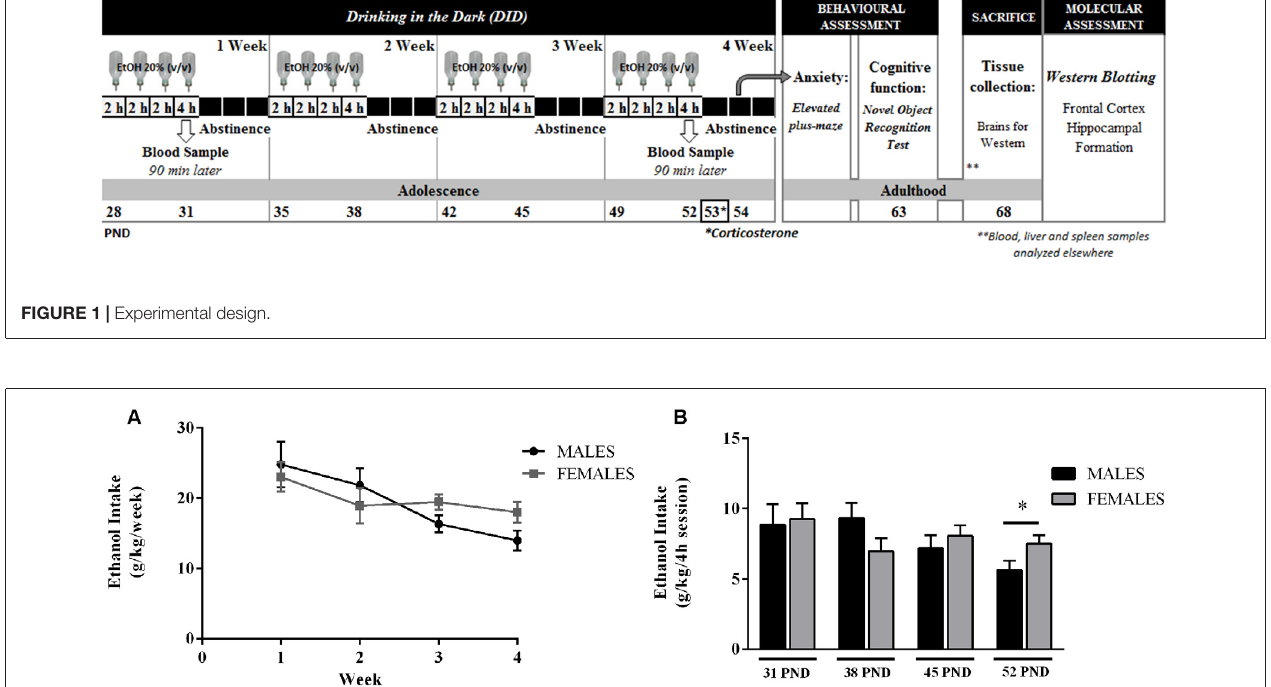
FIGURE 2 | Ethanol consumption during adolescence. Data are presented as mean ± SEM. (A) Weekly ethanol intake (g/kg/week). (B) Average amount of ethanol consumed during the last 4 h session, on the 4th day of each week (g/kg/4 h session). Wistar rats were given access to ethanol (20% in drinking water) or tap water for 2-h sessions during 3 days, and for an additional 4-h session on the 4th day, every week during adolescence, from postnatal days (pnd) 28–52. n = 24 animals per experimental group, coming from 12 litters. p < 0.05; *effect of sex.